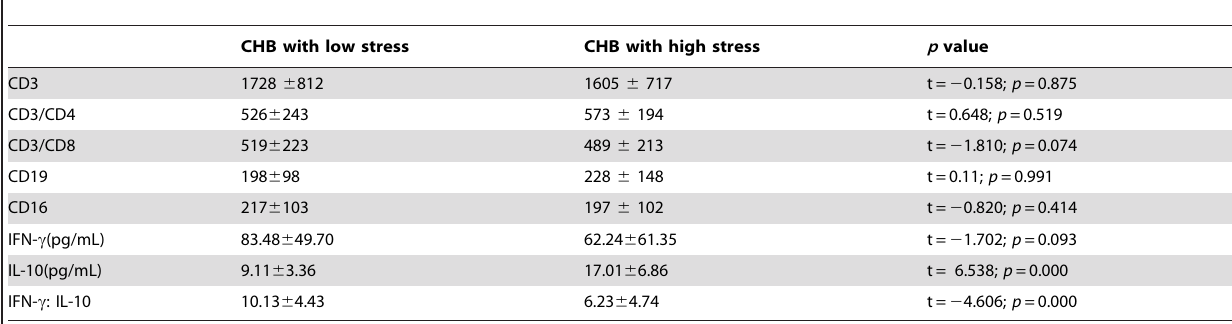
Table 2. Comparison of lymphocytes count and circulating cytokines between low and high perceived stress patients with hepatitis